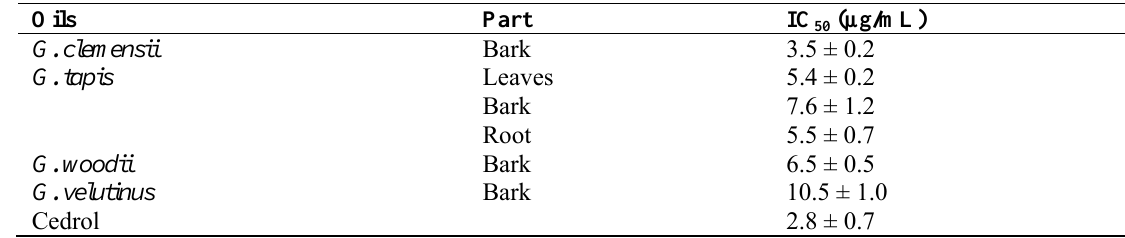
Values were calculated from at least three separate experiments. Values are represented as means ±